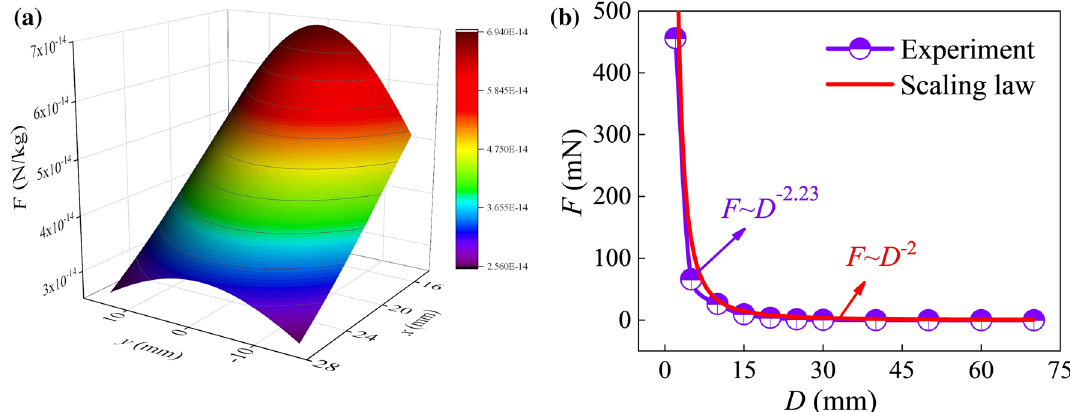
Figure 3. Magnetic force distribution map. ( a ) The cloud map of magnetic force per unit mass of magnetic particles, ( b ) The relationship between magnetic force and the distance D